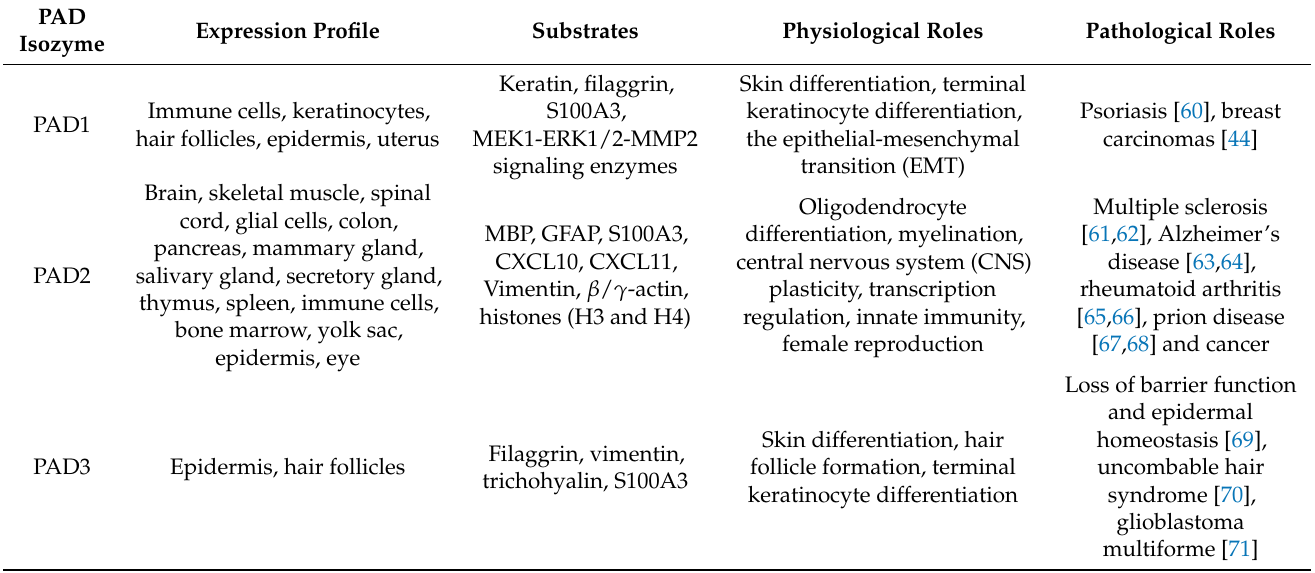
Table 1. Distribution, substrates, and biological functions of PADs and related